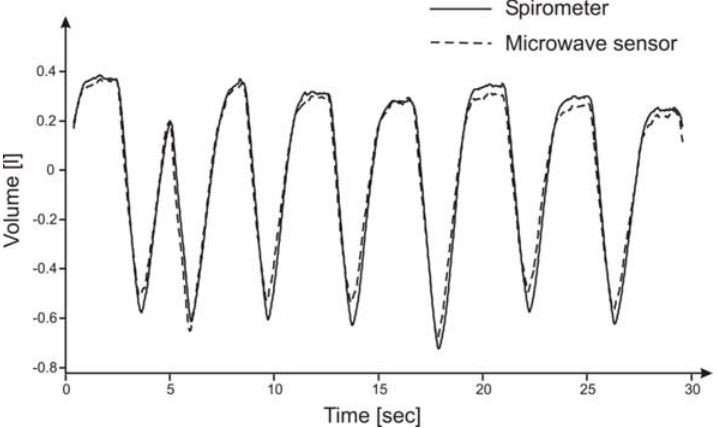
Figure 7. Volume variation measured by spirometer and by microwave sensor after calibration, as a function of time, for a single data